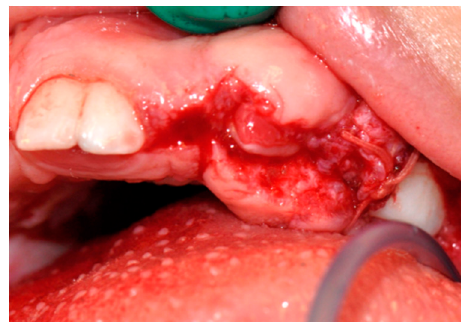
Figure 4. Intra-operative photo: gingivectomy and gingivoplasty surgery .